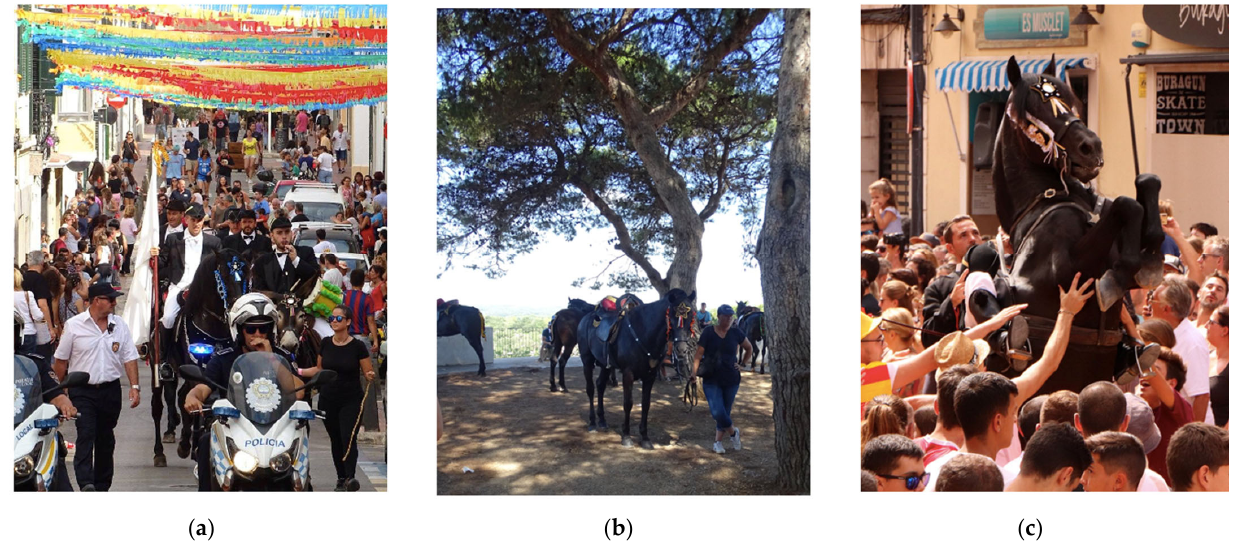
Figure 1. ( a ) Horses and riders during the parade to the church. Photo credits by Trevor Fryatt. ( b ) Horses resting during the celebration of the mass. Photo credits by Trevor Fryatt. ( c ) Horse performing the “bot” in the middle of the crowded main square during a jaleo round. Photo credits by Catalina Pasqual.